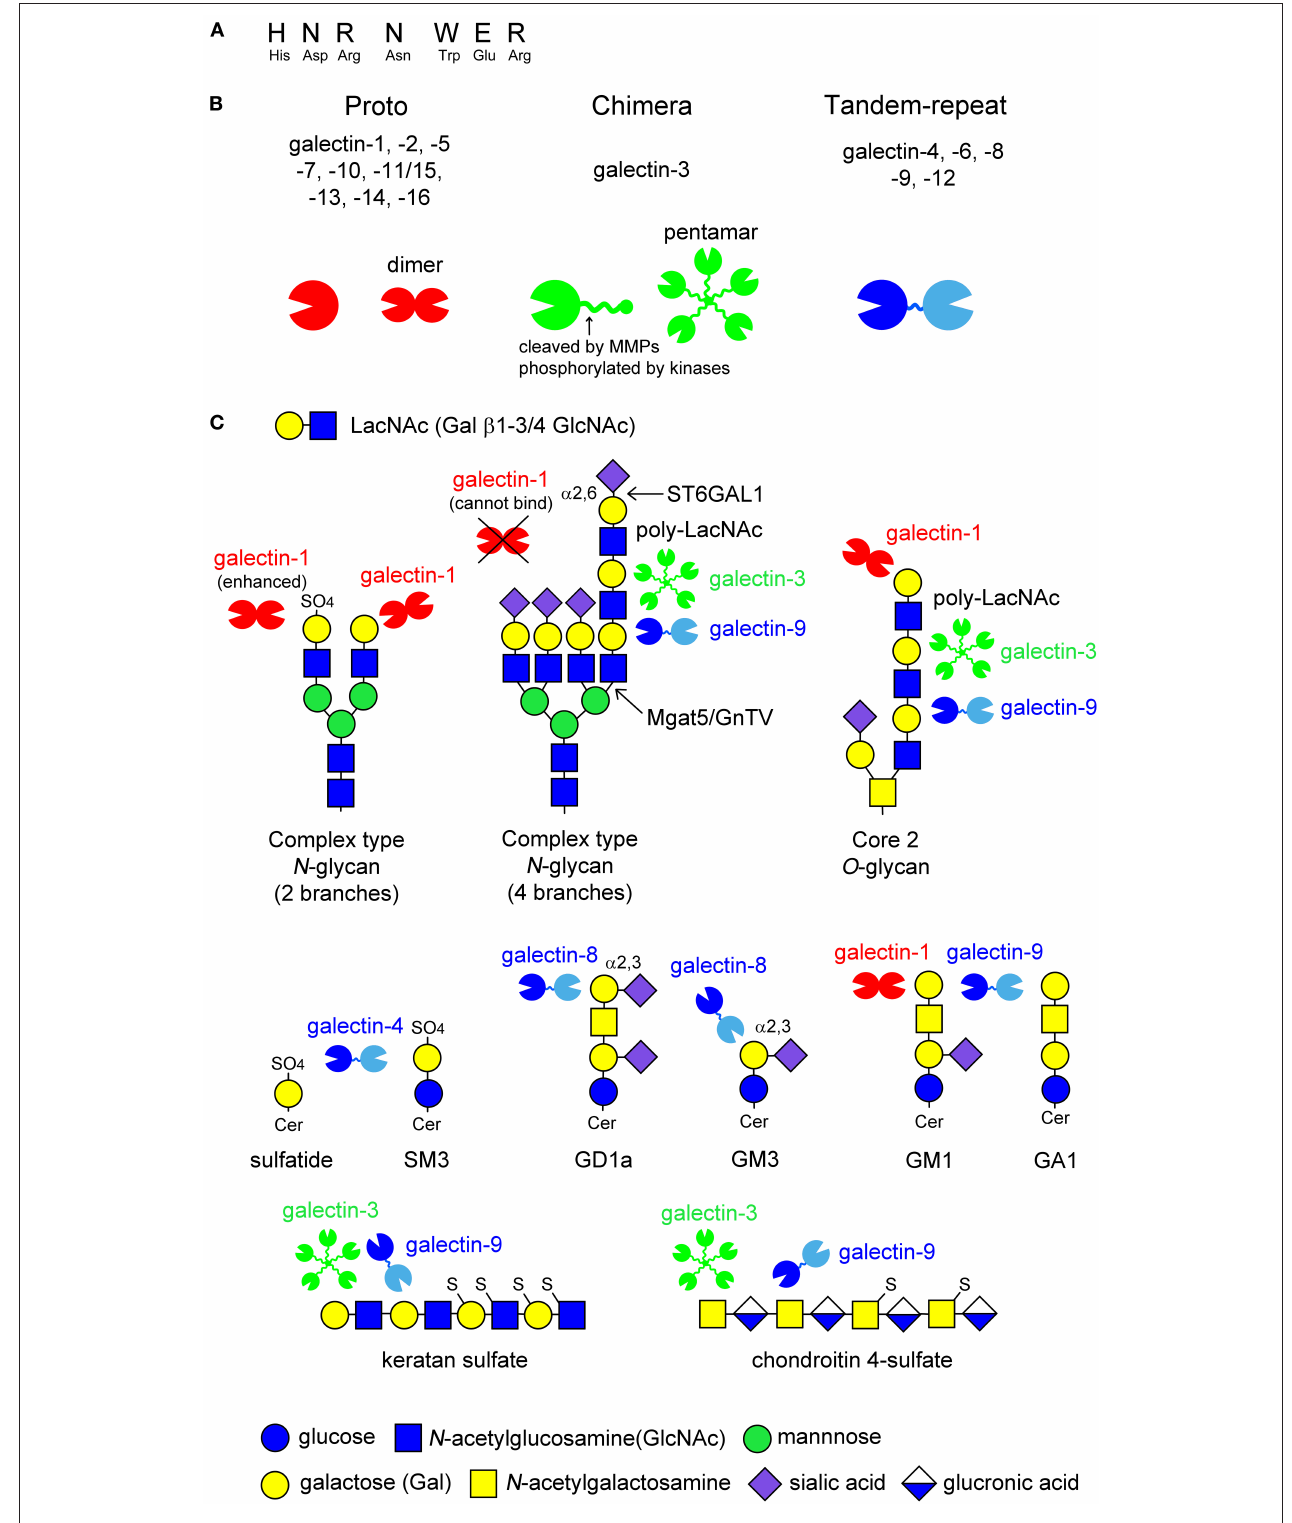
FIGURE 1 | Schematic image of the structure of galectins and the ligand glycans. Galectins contain seven conserved amino acids sequence (A) . Fifteen members of galectins are classified into three types: proto type, chimera type, and tandem-repeat type. Proto type galectins have one carbohydrate recognition domain (CRD) and